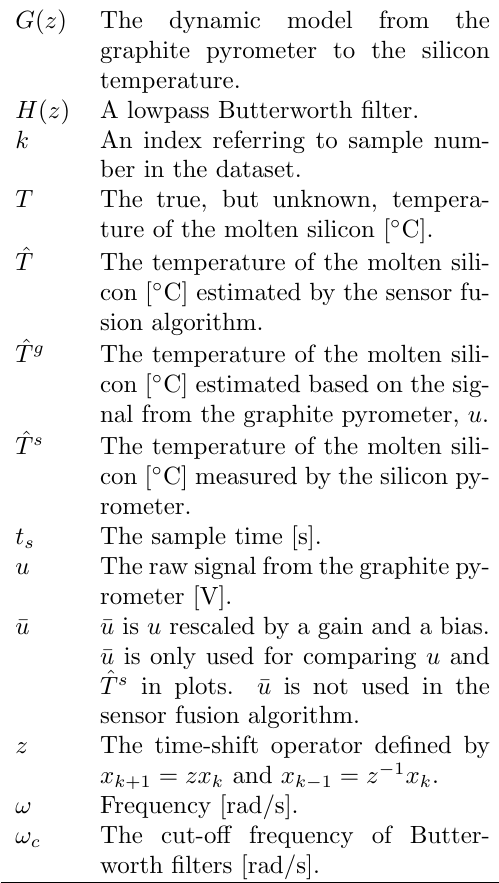
Table 1: Notation used in this paper. The dynamic model from the graphite pyrometer to the silicon temperature.